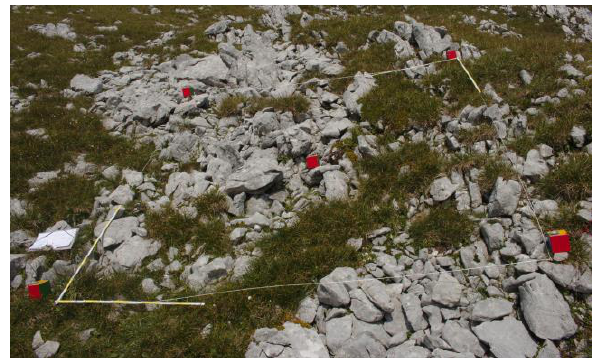
Figure 9. Plot wek_s45, roughness = 13.5